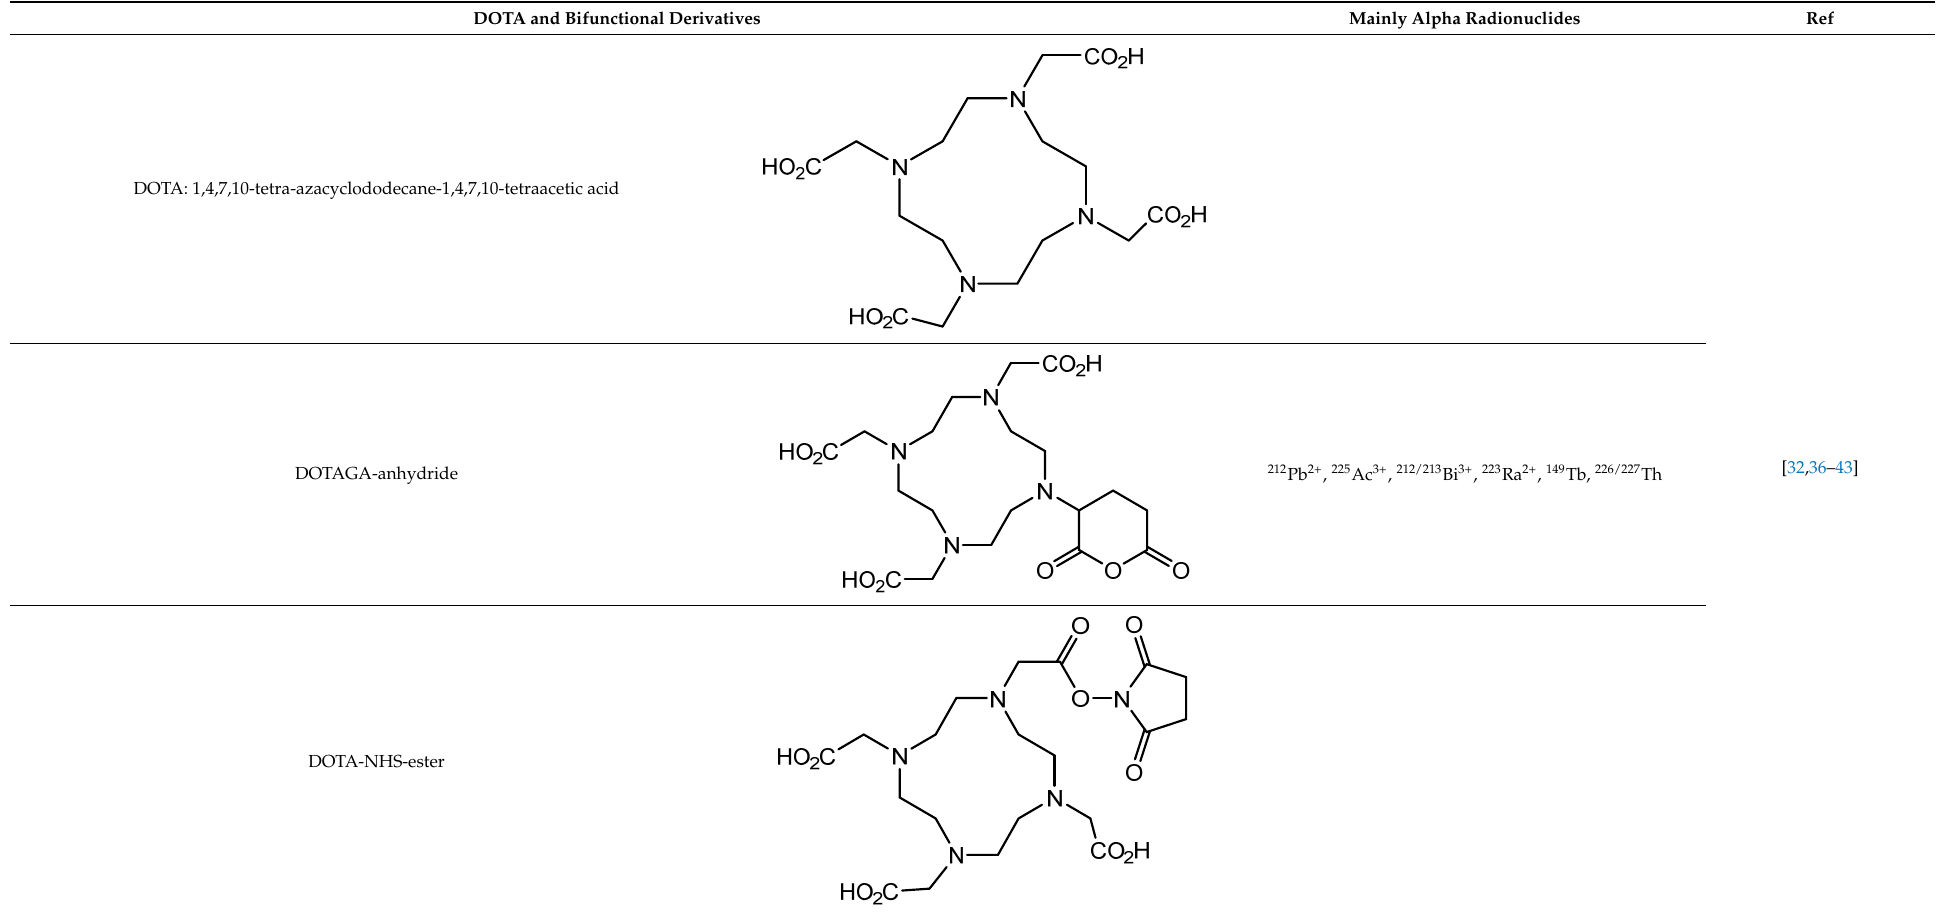
Table 2. Structures of acyclic and macrocyclic common bifunctional reagents used with alpha-emitting radionuclides.